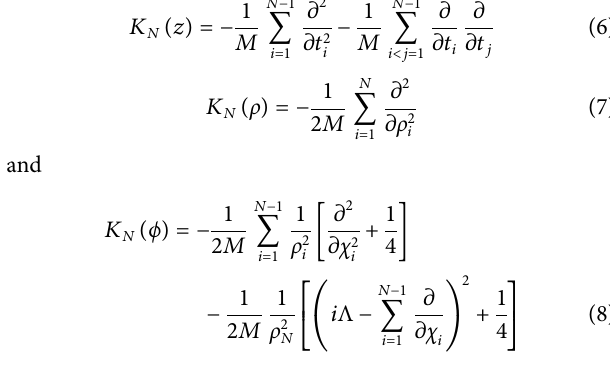
Frontiers in Chemistry |